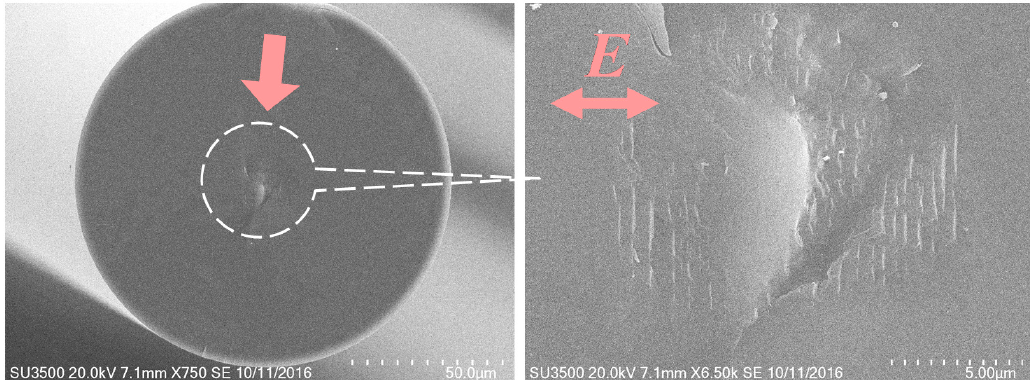
Figure 6. Nanograting nature of Type II-IR FBGs in SMF-28 fiber, as revealed using SEM. The figure on the left shows the cross section of optical fiber with a Type II-IR grating present. The right figure is a magnified view of the modified portion of the fiber in the left figure. The nanogratings were produced using chirped 150 fs pulses, a NA = 0.2 cylindrical lens and a 3.21 µm pitch mask. The pulse energy was 900 µJ.